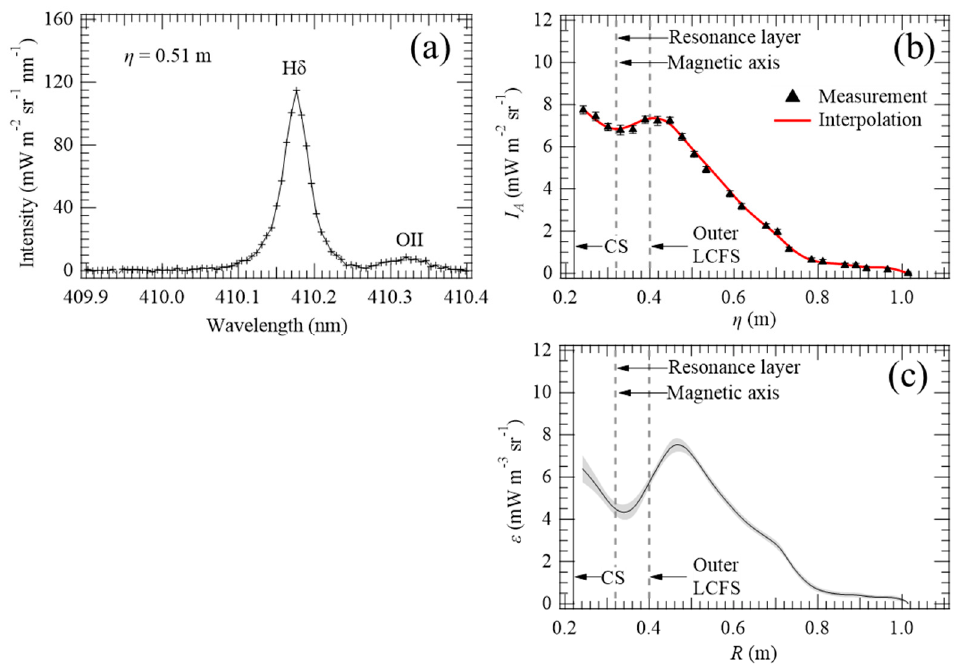
Figure 3. ( a ) H δ spectrum measured on the viewing chord at η = 0.51 m (#41178). ( b ) Chord-integrated H δ intensities and the interpolated curve. ( c ) Radial distribution of H δ emissivity obtained using Abel inversion.